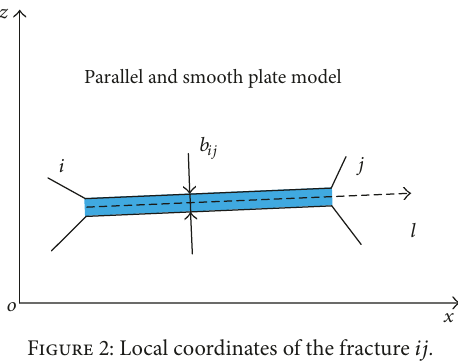
Figure 3: Mass conservation at fracture intersection 𝑖